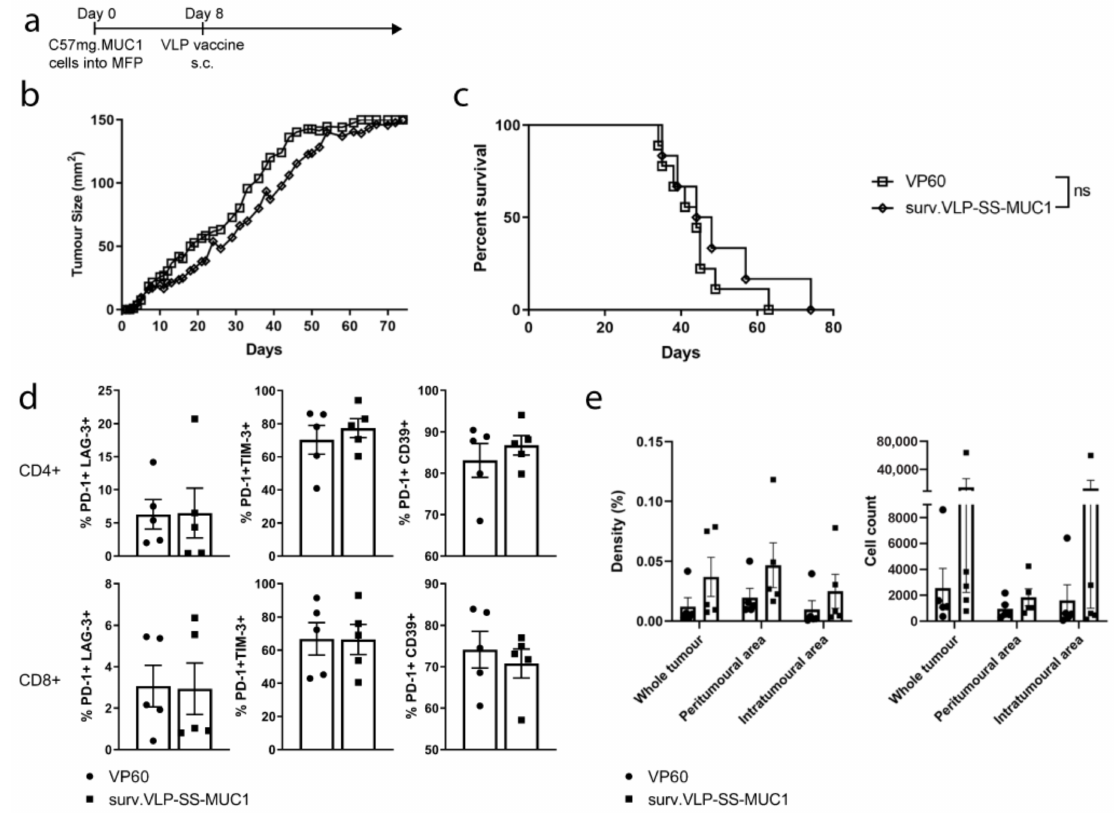
Figure 4. Anti-tumour responses in MUC1.Tg mice induced by surv.VLP-SS-MUC1 therapeutic vaccination. ( a ) Timeline of tumour trial. MUC1.Tg mice ( n = 10 mice per treatment group) were inoculated with C57mg.MUC1 tumour cells in the mammary fat pad (MFP). Once tumours were palpable (day 8), mice were vaccinated with surv.VLP-SS-MUC1 or